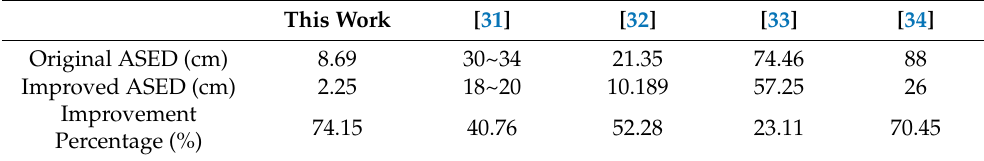
Table 2. Comparison of improvement results obtained using different